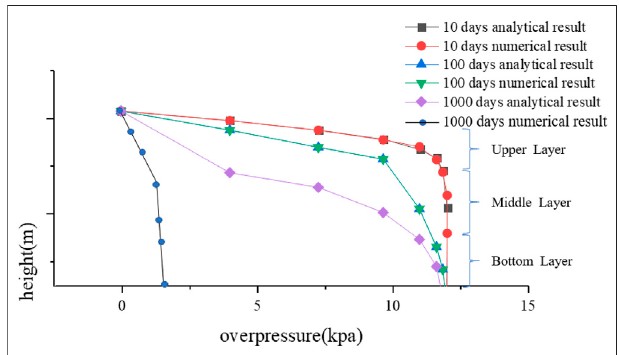
FIGURE 4 | Comparison of overpressure evolution of three layers with different properties between analytical and numerical results for 10, 100, 1,000 days.